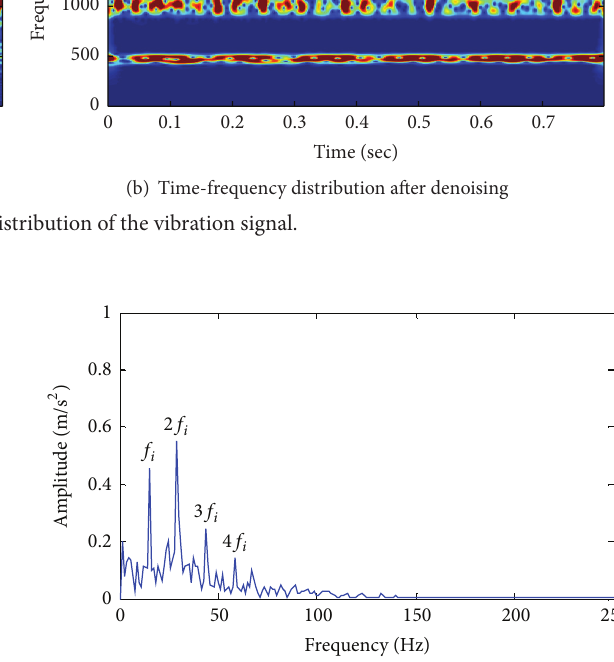
Figure 18: Envelope spectrum of reconstruction signal after